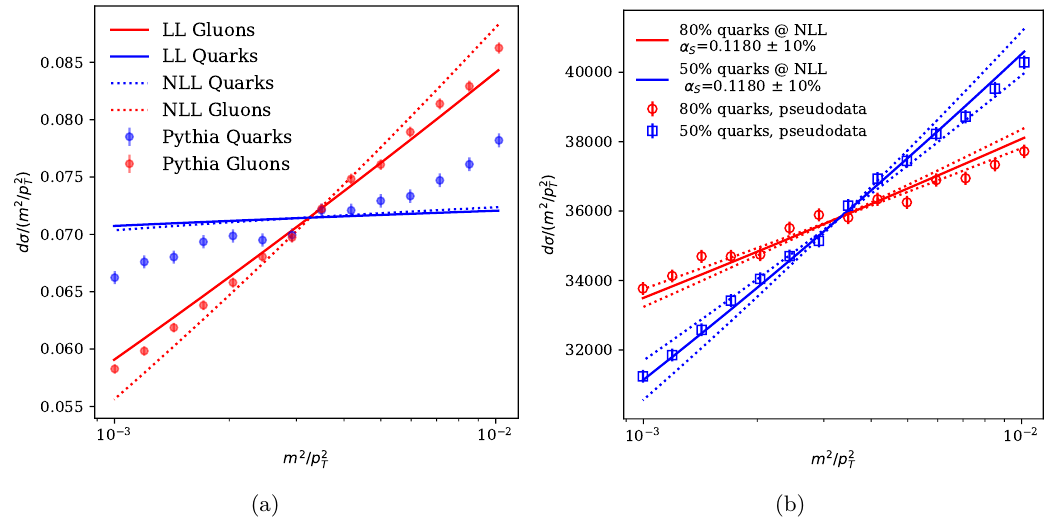
Figure 4 . (left) Comparison of Pythia soft-drop mass prediction to LL and NLL theory predictions. (right) Example pseudodata generated from the NLL theory